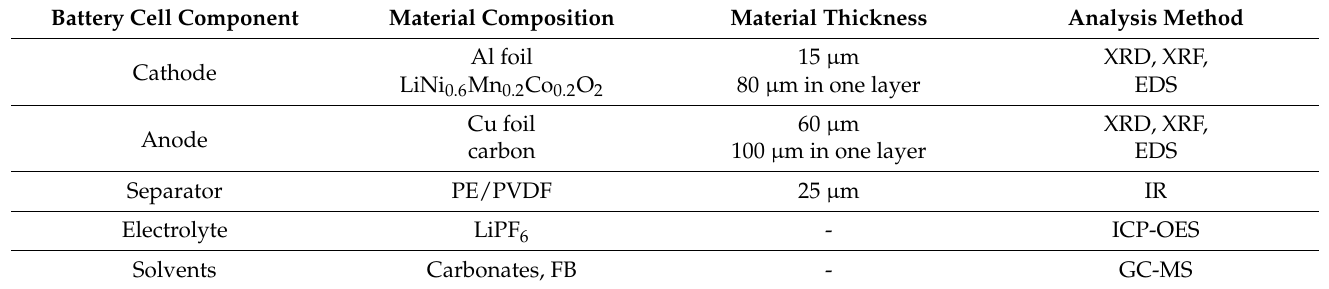
Table 1. The material composition of the individual components of the battery cell; average thick- nesses of individual material layers; methods used to characterize the material composition.